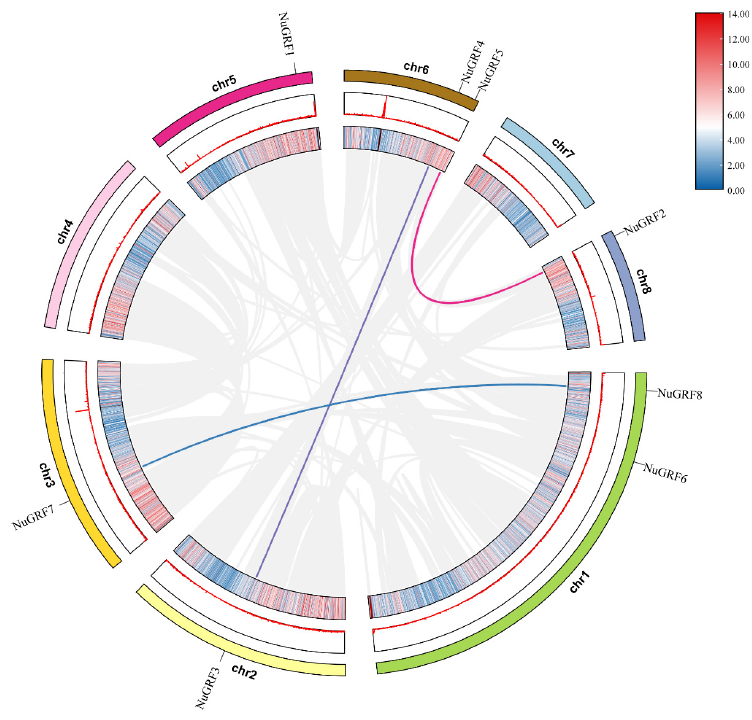
Figure 4. Chromosome distribution and microsynteny relationships among NuGRFs. Lines denote syntenic GRF gene pairs of N. nucifera on the chromosomes. ch1~ch8 represent the eight chromosomes of N. nucifera.